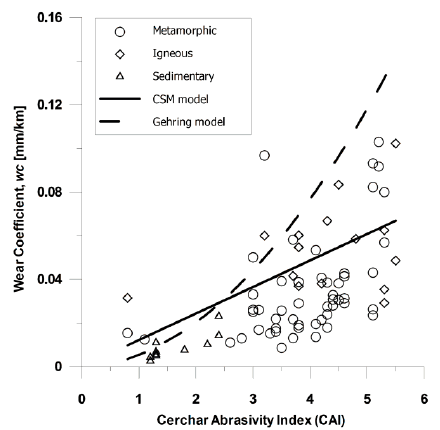
ffi cient and Cerchar Abrasivity Index ( CAI Figure 1. Relationship between wear coefficient and Cerchar Abrasivity Index (CAI). Figure 1. Relationship between wear coe